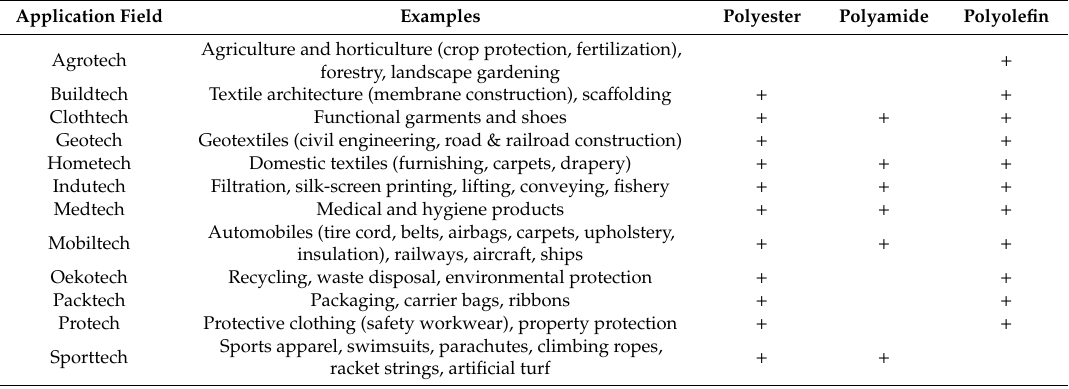
Table 5. Technical textiles: Classification [193], applications and the three most common polymer classes for respective melt-spun fibers (indicated with +